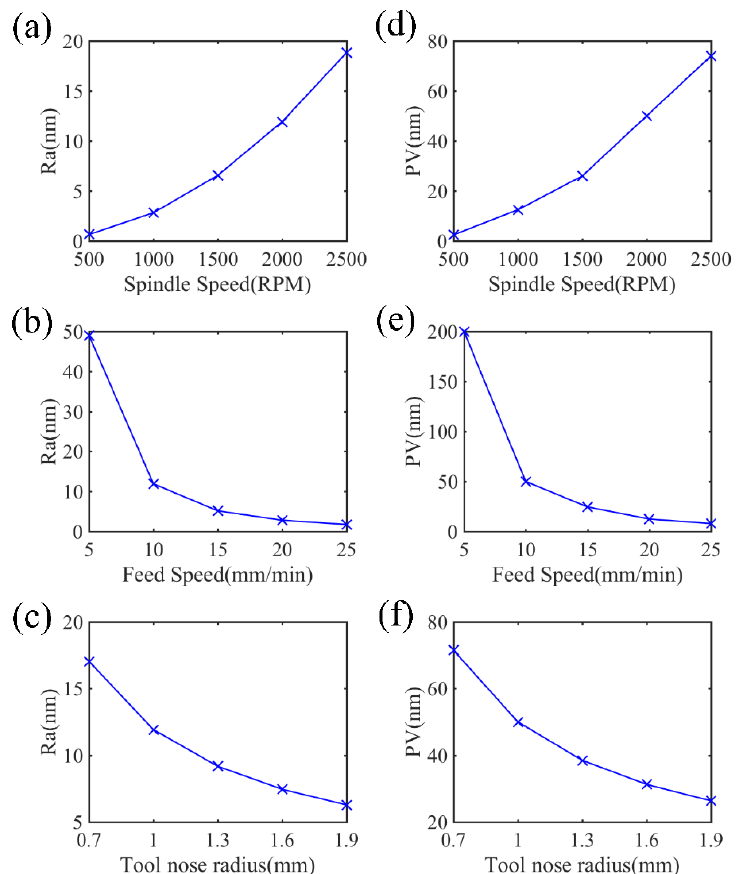
Figure 7. Effects of cutting parameters and the tool nose radius on the surface quality. Here, ( a – c ) show the trend of the surface roughness ( R a ) and ( d – f ) show the trend of the peak to valley height ( PV ) with different cutting parameters.